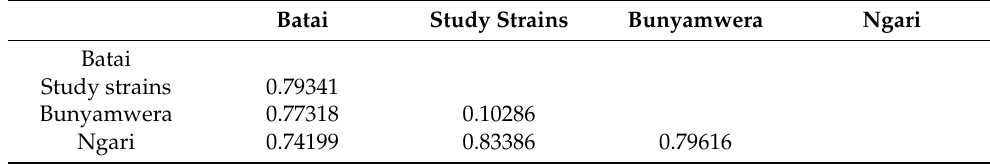
Table 3. Estimates of FST between groups.